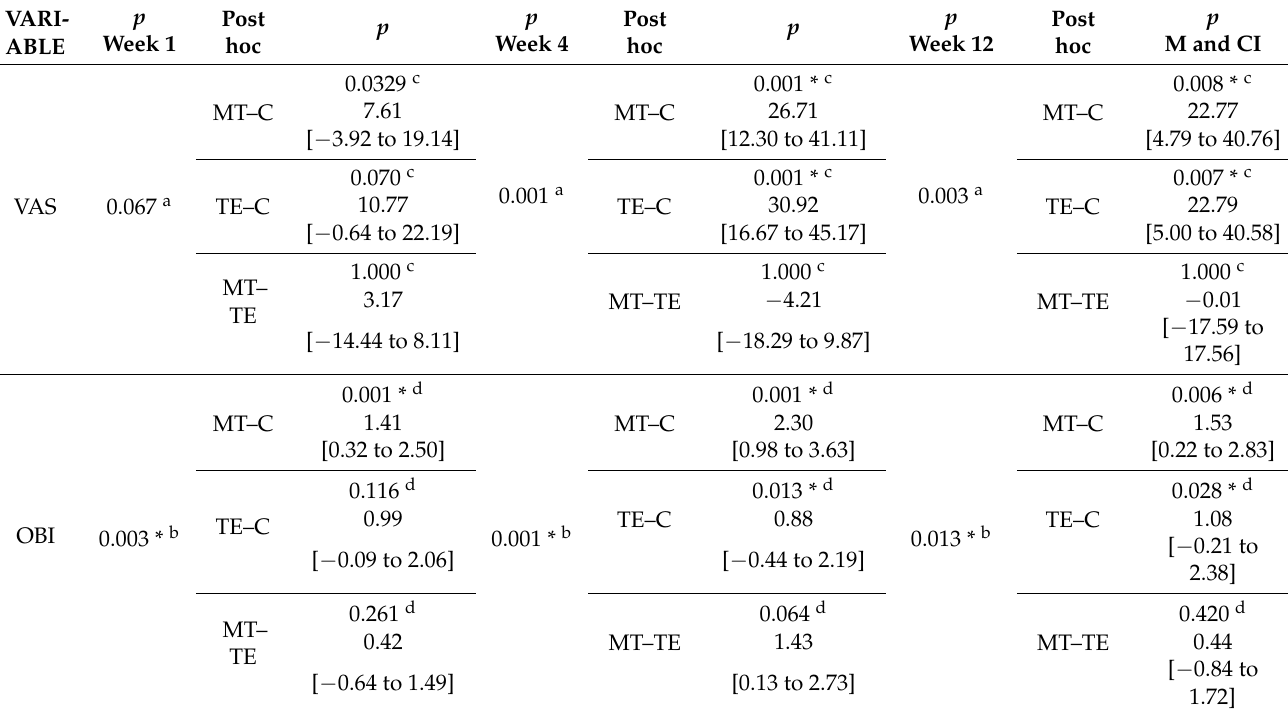
Table 4. Intergroup